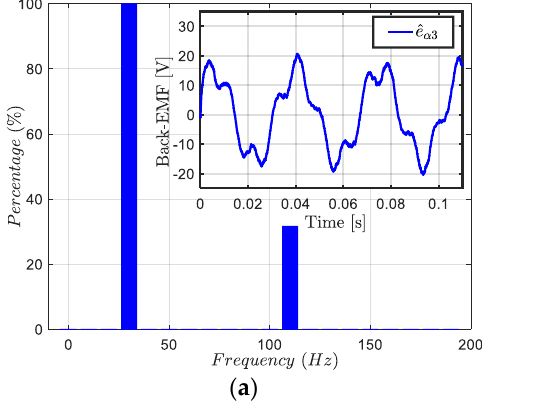
Figure 13. Simulation waveforms of the actual back EMF of the 3rd harmonic and the estimated back EMF through TM in the α -axis using the methods of harmonics separation.